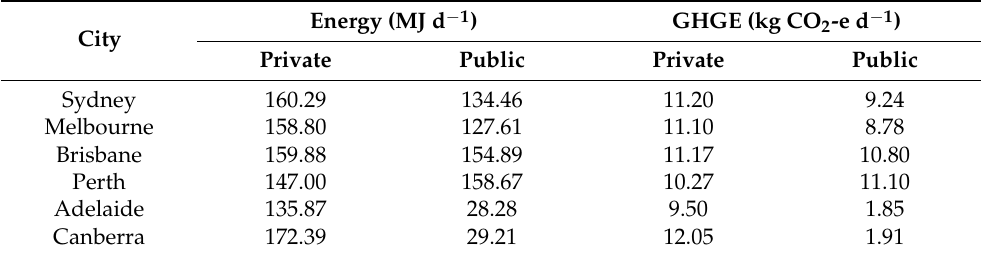
Table A4. Daily transport energy consumption and GHGE per employee.